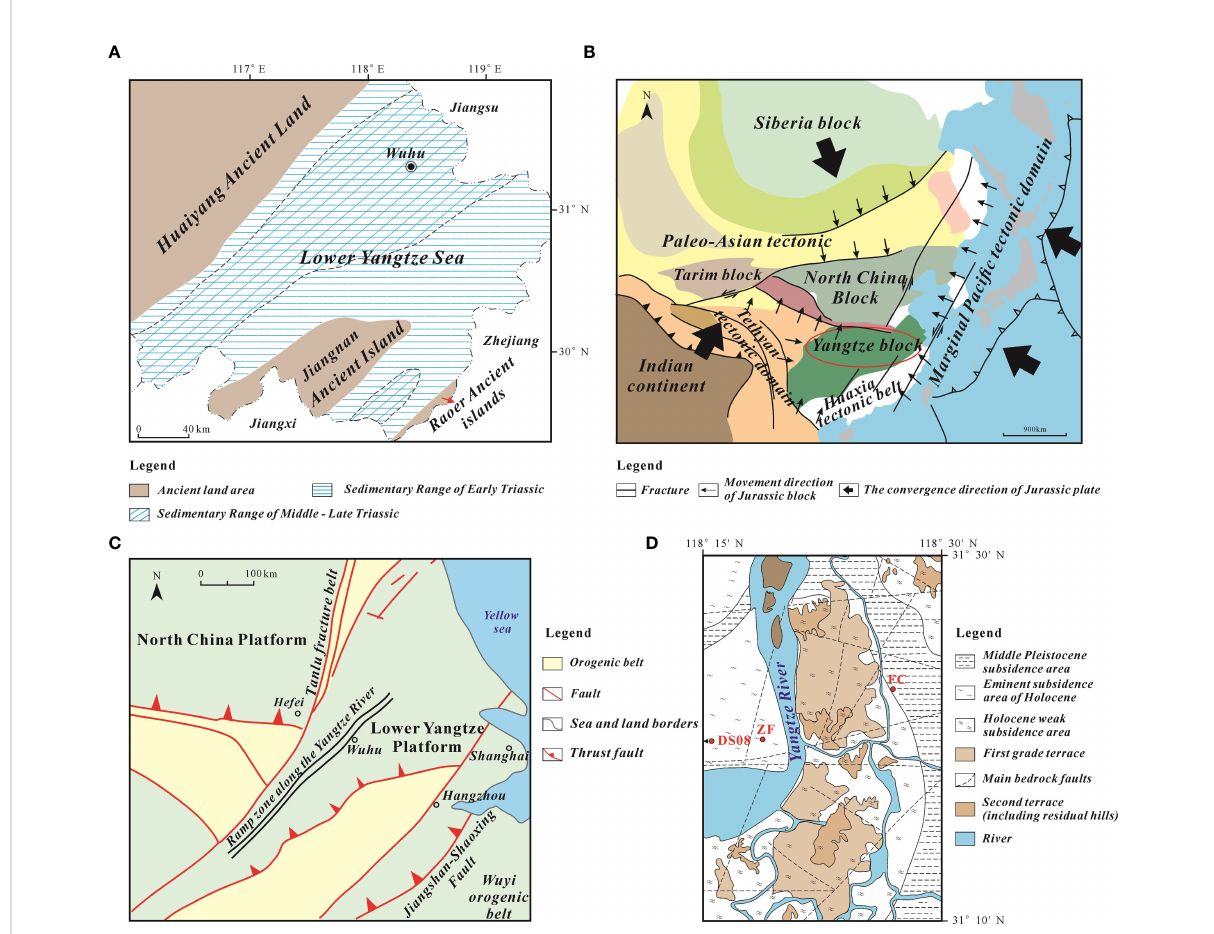
(the crustal movement occurring since the Neogene) and relative stability of the crust in the study area (Qiu,